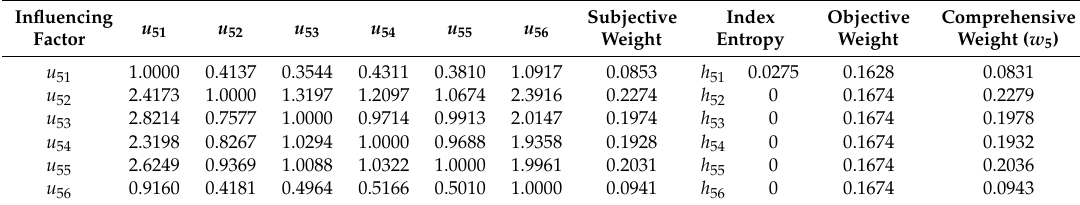
Table 23. The weights of the MU influencing